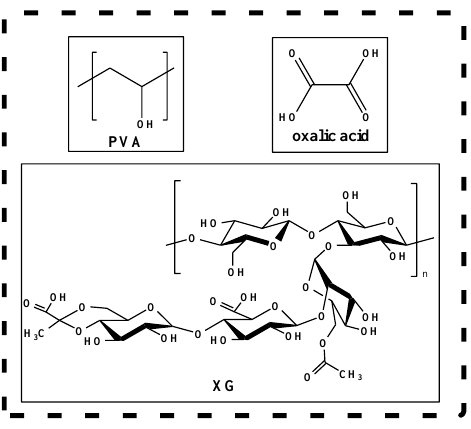
Figure 1. Chemical structure of PVA, XG, and oxalic acid.